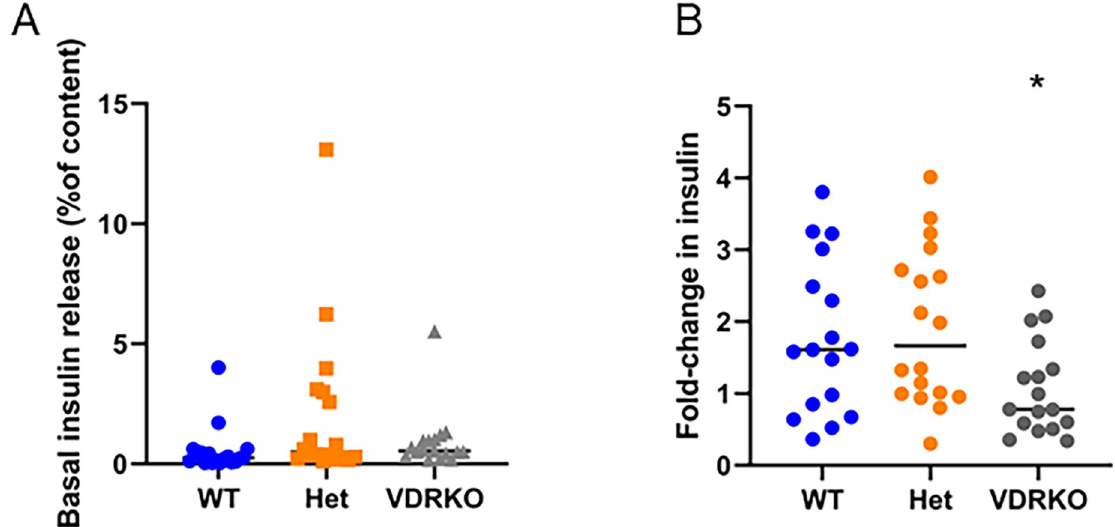
Fig 5. Insulin release from isolated islets in females. A) Low glucose (1mM) insulin release expressed as a percentage of total insulin content. B) Fold-increase with 25mM glucose compared to 1mM glucose for each set of islets. � p < 0.05 for VDRKO versus WT, non- parametric testing. N � 12 per